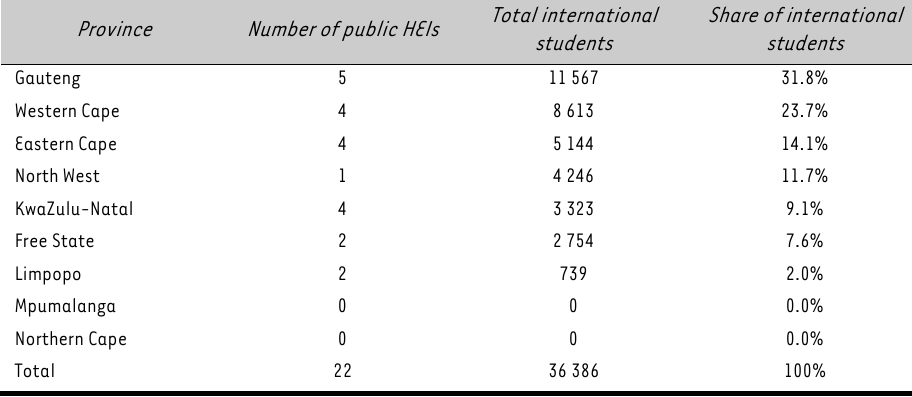
TABLE 1: International students at public universities by province